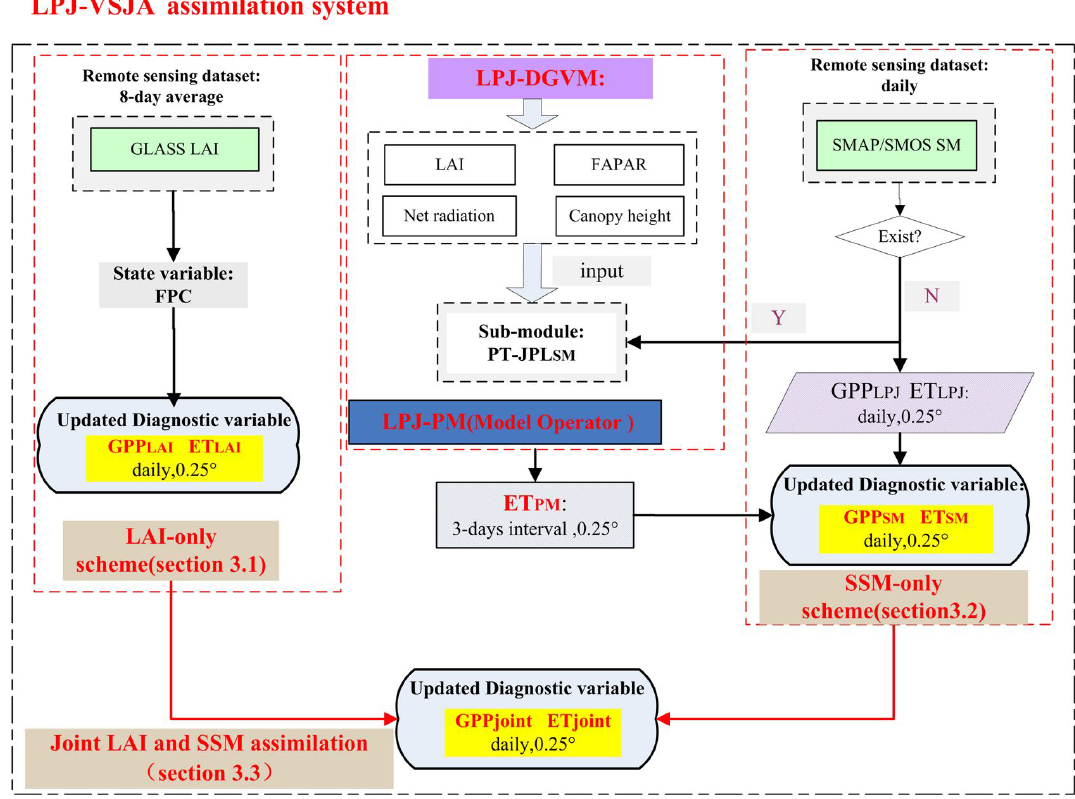
Figure 1. Flowchart of the LPJ-VSJA assimilation scheme: three assimilation schemes and the coupled model: LPJ-PM (adapted from Li et al., 2020). The abbreviations in the model and the assimilation framework are explained in Table